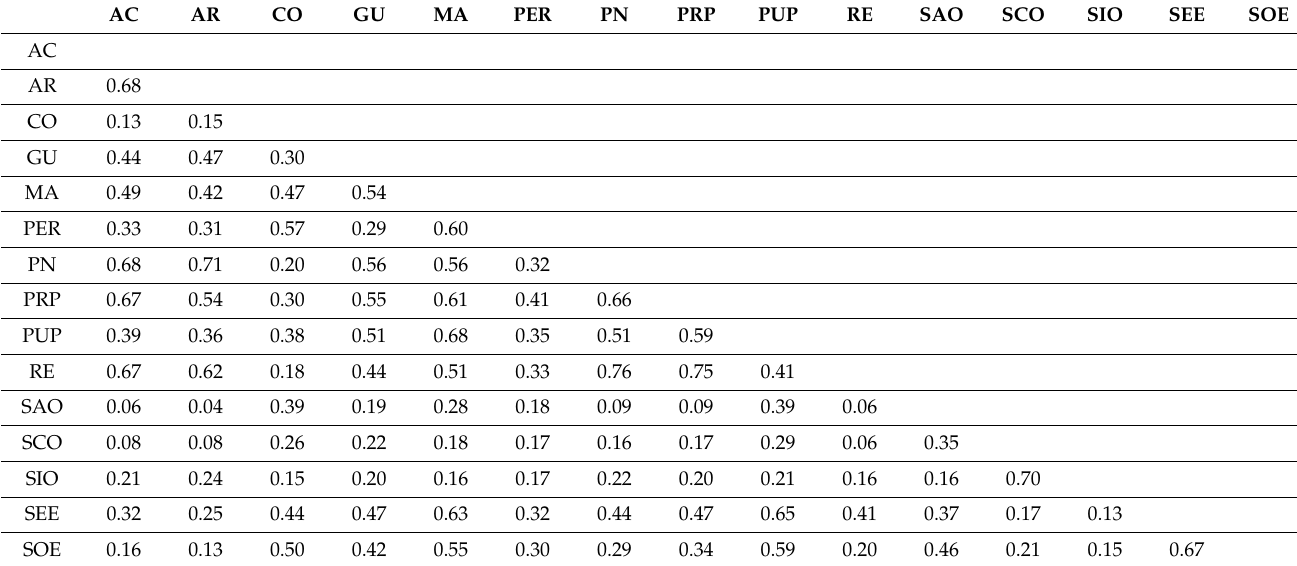
Table 2. Heterotrait-Monotrait Ratio (HTMT).